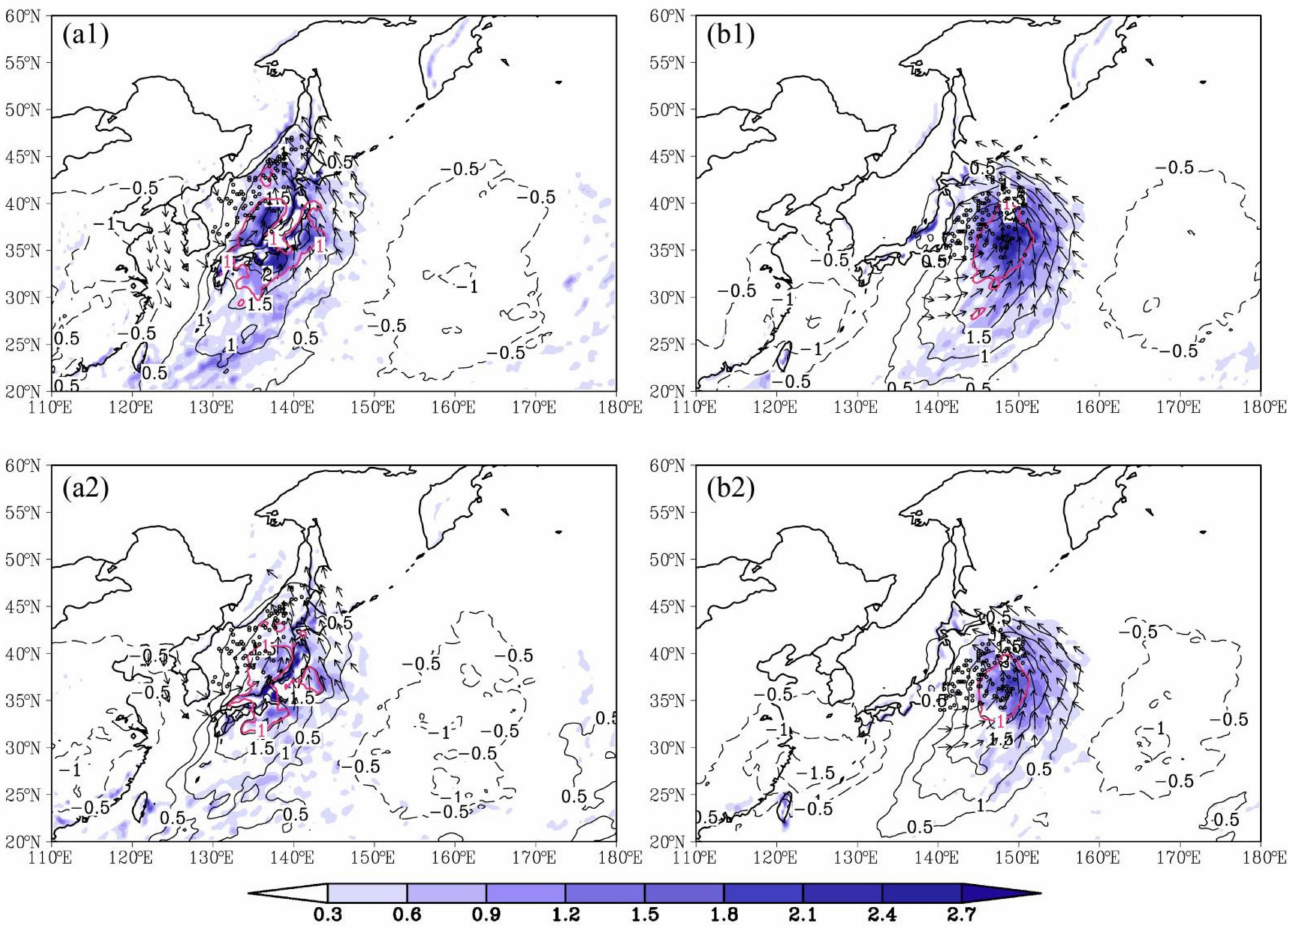
Figure 10. Anomaly fields of composite horizontal wind vector (arrow, ≥ 8 m s − 1 ), specific humidity (black line, 0.5 g kg − 1 intervals) and water vapor convergence (shaded, 0.3 × 10 − 4 g kg − 1 s − 1 intervals) for ECs at maximum-deepening-rate moment over ( a1 , a2 ) the Japan Sea and ( b1 , b2 ) Kuroshio/Kuroshio Extension at ( a1 , b1 ) 925 hPa and ( a2 , b2 ) 850 hPa. The red line indicates the RAS of potential temperature equal to 1 or −